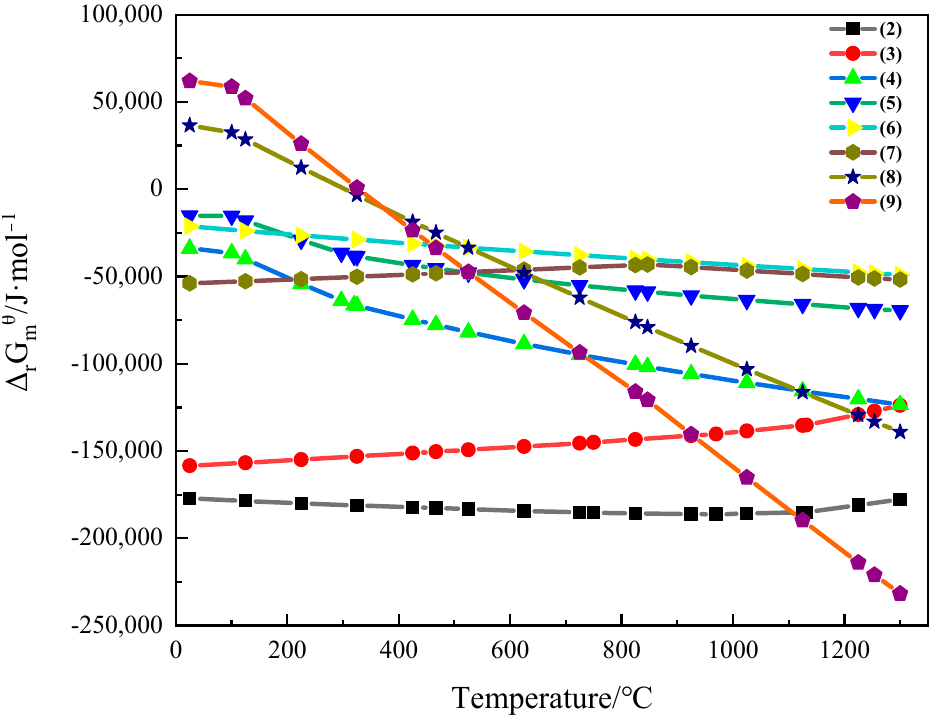
Figure 4. Change of the standard Gibbs free energies of possible reactions (2)–(9) in the modified process.